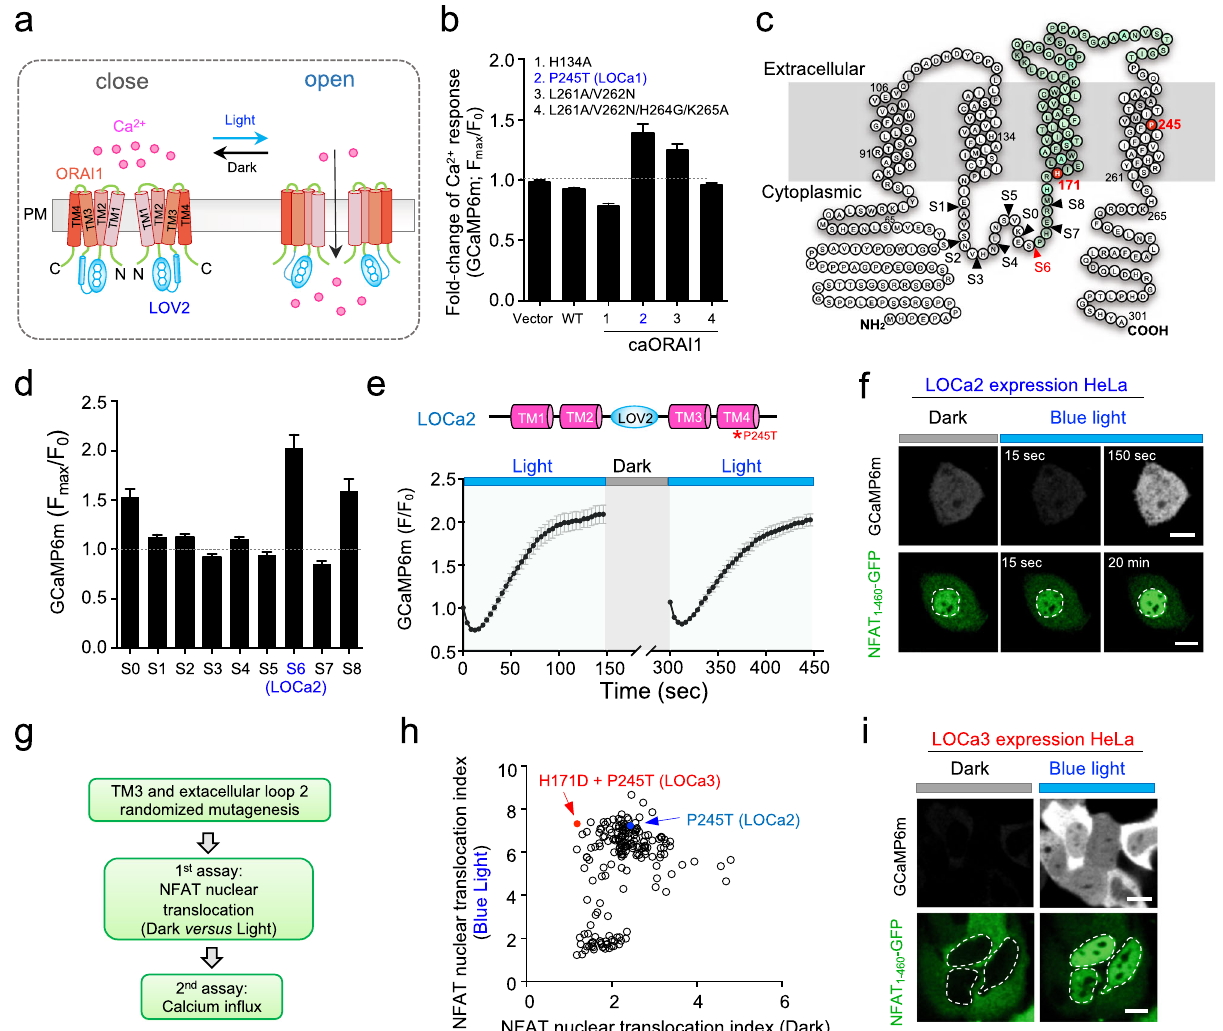
Fig. 1 Design of a light-operated calcium channel (LOCa). Data are shown as mean ± s.e.m. a Schematic depiction of photo-switchable Ca 2 + in fl ux through an engineered ORAI1 Ca 2 + channel. The LOV2 domain is inserted into the intracellular loop of a constitutively active ORAI1 (caORAI1), which maintains the hybrid channel in a largely closed state in the dark. Upon photosimulation at 470 nm, conformational changes within LOV2 trigger allosteric activation of engineered ORAI1 to evoke Ca 2 + fl ux across the plasma membrane. b The fold-change of photo-induced Ca 2 + responses reported by GCaMP6m in HeLa cells expressing LOV2 – ORAI1 hybrid variants. LOV2 was inserted between residues R167 and M168. The mutant P245T showed the most notable light-induced changes in intracellular Ca 2 + (designated LOCa1). n = 24 – 52 cells. c Snake-like diagram of the ORAI1 Ca 2 + channel. The LOV2 insertion sites tested in the study are indicated as arrowheads. TM3 and the second extracellular loop regions targeted for randomized mutagenesis are highlighted in green. d Comparison of light-induced Ca 2 + changes after inserting LOV2 into the indicated positions of the ORAI1-P245T variant. S6 showed the highest light-dependent changes and was named as LOCa2. n = 22-66 cells from three independent assays. e Light-induced changes in cytosolic Ca 2 + reported by GCaMP6m in HeLa cells transfected with LOCa2. Two cycles of light stimulation were applied. The domain architecture of the construct is shown above the curve. Blue bar, photo-illumination at 470 nm with a power density of 40 µ W/mm 2 . n = 24 cells from three independent assays. f Blue light modulated Ca 2 + entry (top) and NFAT nuclear translocation (bottom) in HeLa cells expressing LOCa2. Scale bar, 10 μ m. g The experimental fl ow for high-throughput screening of evolved LOCa constructs. h Biplot showing the degrees of NFAT nuclear translocation in HeLa cells expressing evolved mutants, either in the dark ( x -axis) or under photo-illumination ( y -axis). The construct showing the least dark activation and high Ca 2 + response in the lit- condition was designated LOCa3, which bears two mutations in ORAI1: H171D and P245T. i Representative confocal images showing blue light-triggered Ca 2 + response and changes in subcellular localization of NFAT 1-460 -GFP. Scale bar, 10 μ